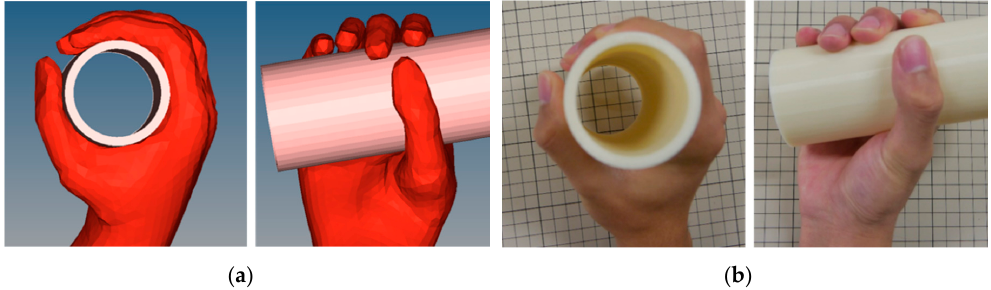
Figure 8. Comparison of final grasping posture while gripping a cylinder. ( a ) FE simulation. ( b ) Volunteer experiment.